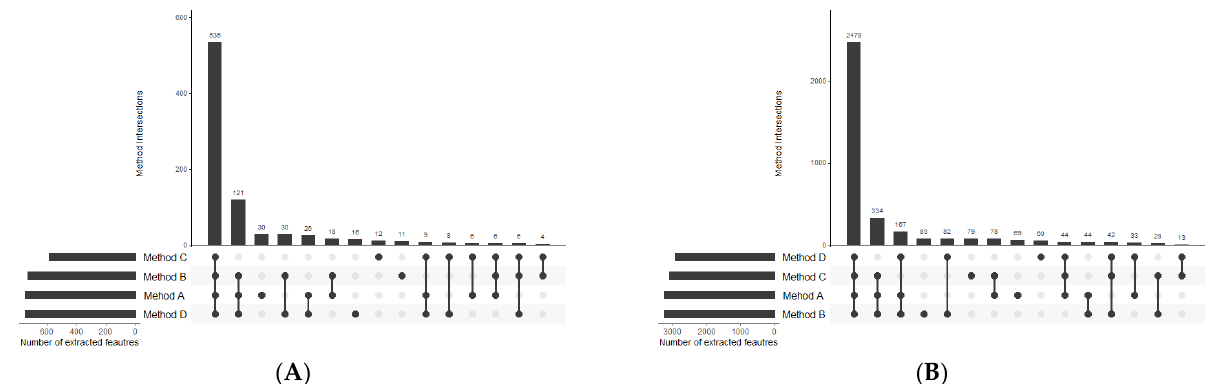
Figure 4. Summary of the number of features detected in organic extracts using RP-LC-MS in ( A ) positive and ( B ) negative ionization modes.